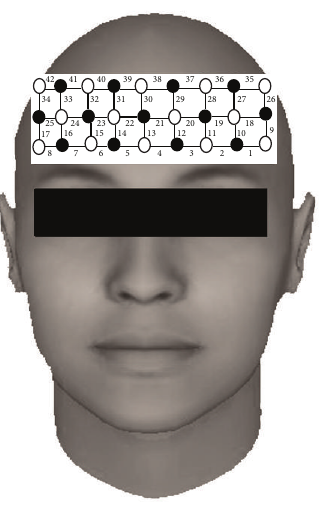
Figure 2: Location of the 42 channels with the 3 × 9 probe holder. Circles are emitters (open) and detectors (closed). The numbers indicate channels’ number.